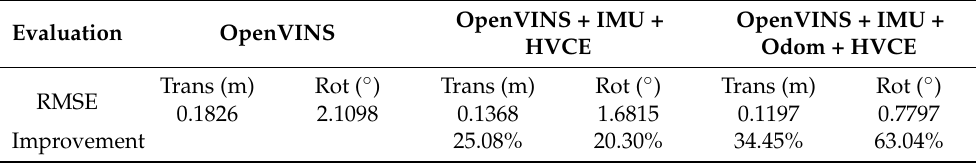
Table 1. The Root Mean Square Error (RMSE) results of OpenVINS and the proposed algorithm. Evaluation